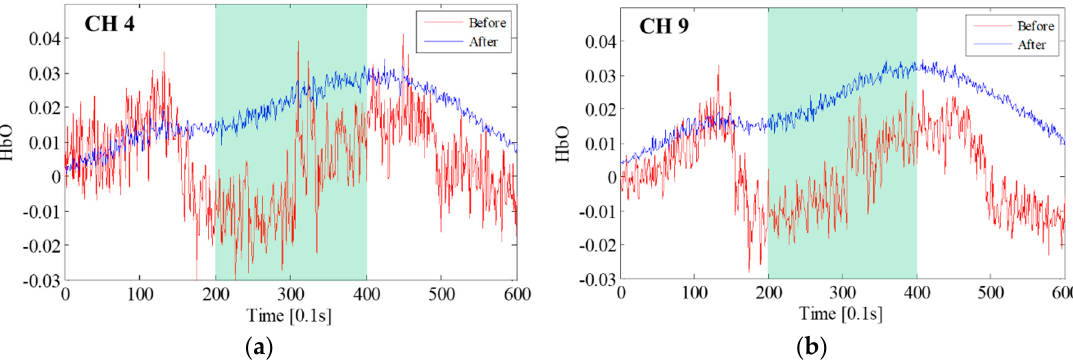
Figure 9. Deep neural network wavelet linear regression: ( a ) fNIRS signal correction of CH 4; ( b ) restoration and correction of CH 9 by using the obtained network weights (the green background indicates the task block).